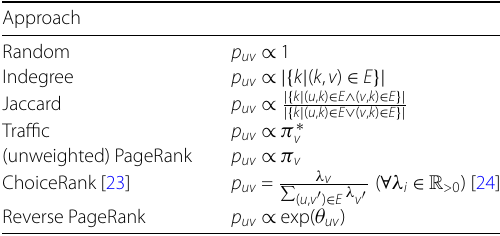
Table 1 Overview of the different approaches for approximating p